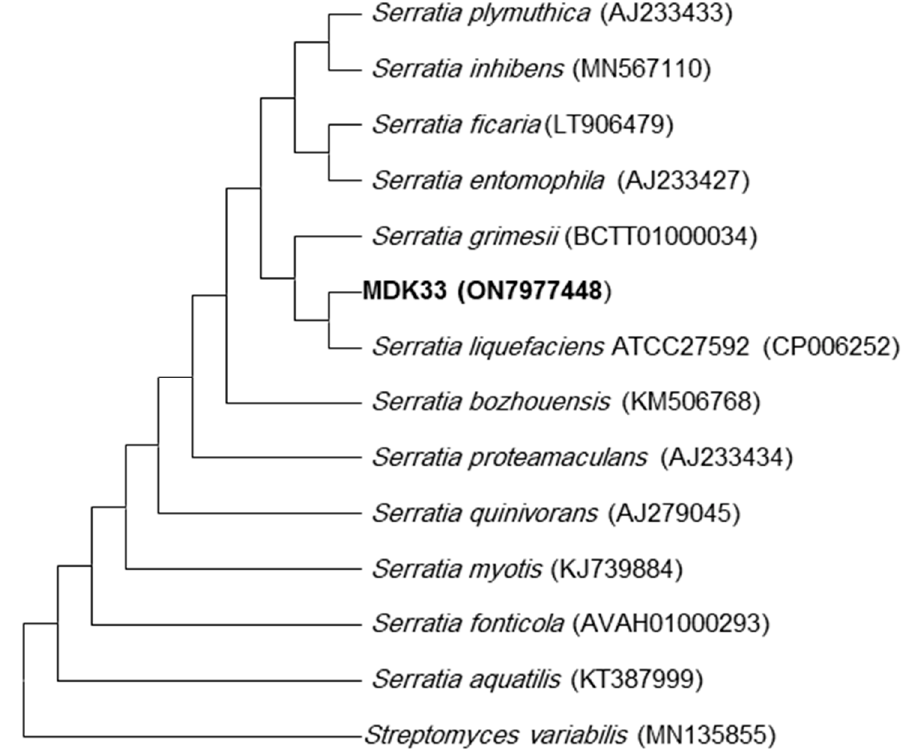
Figure 2. Evolutionary relationships of MDK33 (accession number: ON797448) and other related bacterial species as inferred using the neighbor-joining method. Accession numbers of the 16S rRNA gene sequences are given between parentheses adjacent to each bacterial species.